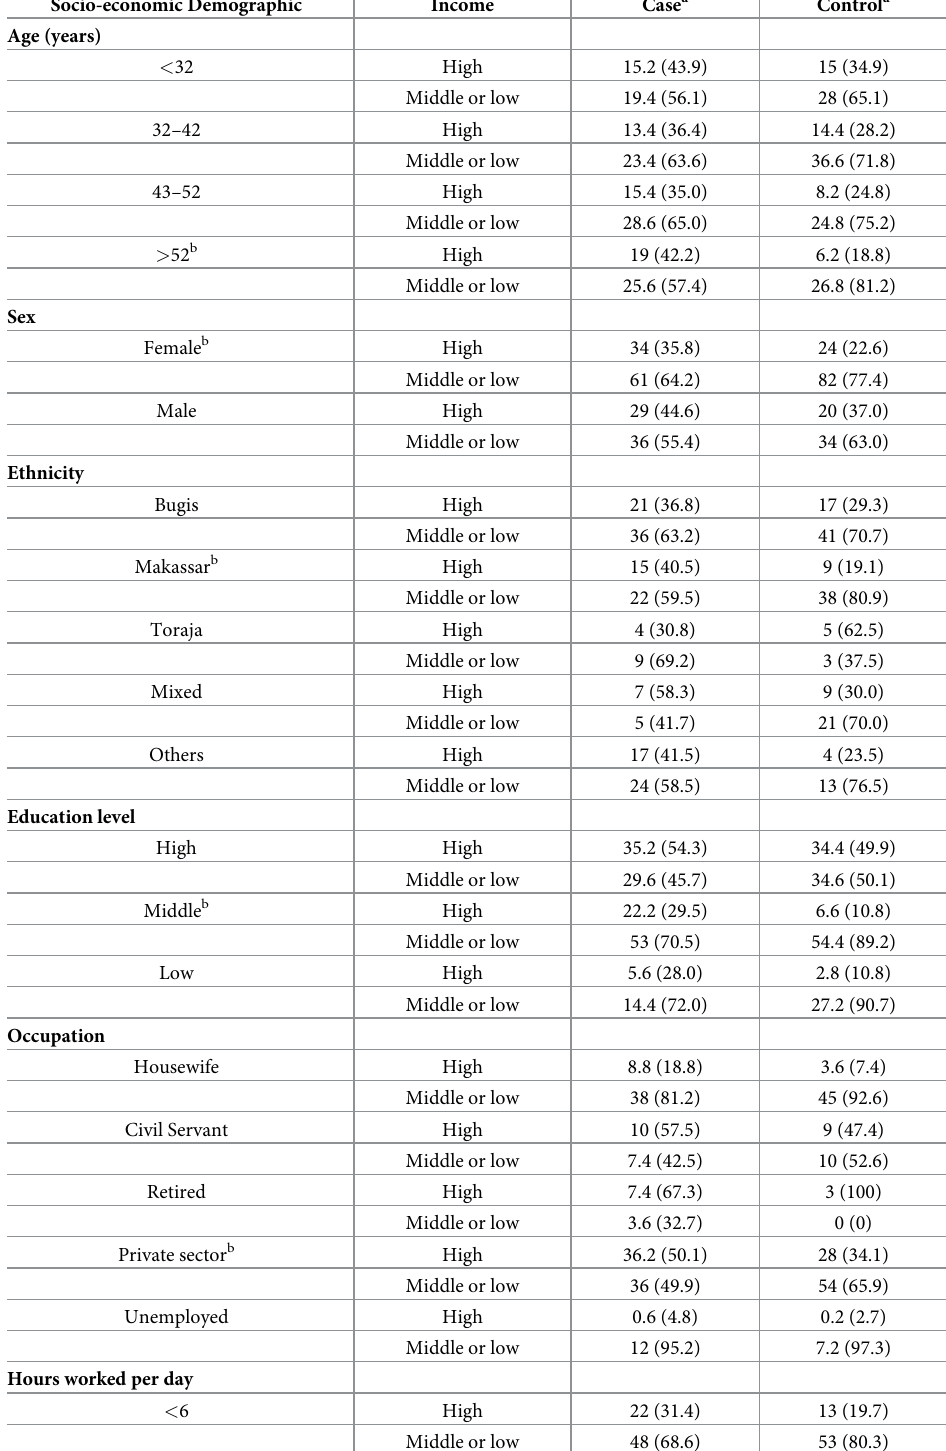
Table 5. Proportion of high-income participants in different socio-economic-demographic classes, by case and control